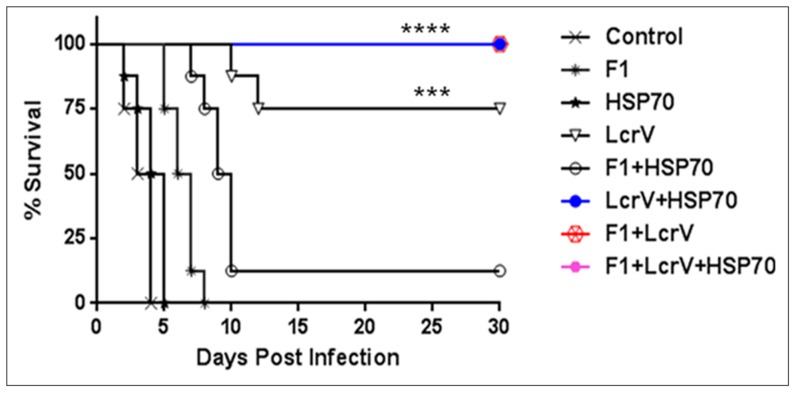
Determination of survival of Balb/C mice infected with Y. pestis.The immunized and PBS control groups (8 mice/group) were challenged with 100 LD50 of Y. pestis (S1 strain). The protective efficacy of vaccine candidate alone or in mixture of antigens was determined by Kaplan Meier's method to compare percentage survivals (****P<0.0001, ***P<0.001).